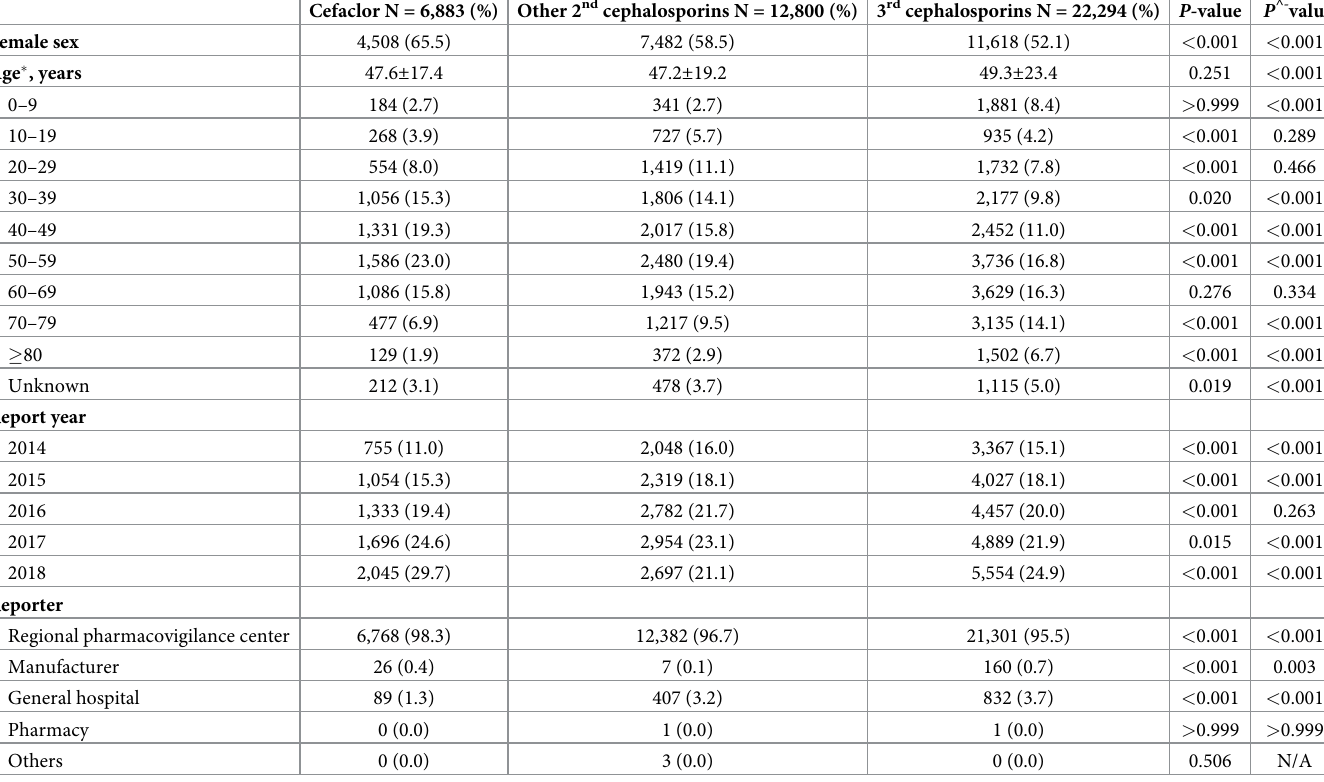
Table 2. Characteristics of adverse drug reaction cases to cefaclor and other 2 nd and 3 rd cephalosporins in the Korean Adverse Event Reporting System database for the most recent 5